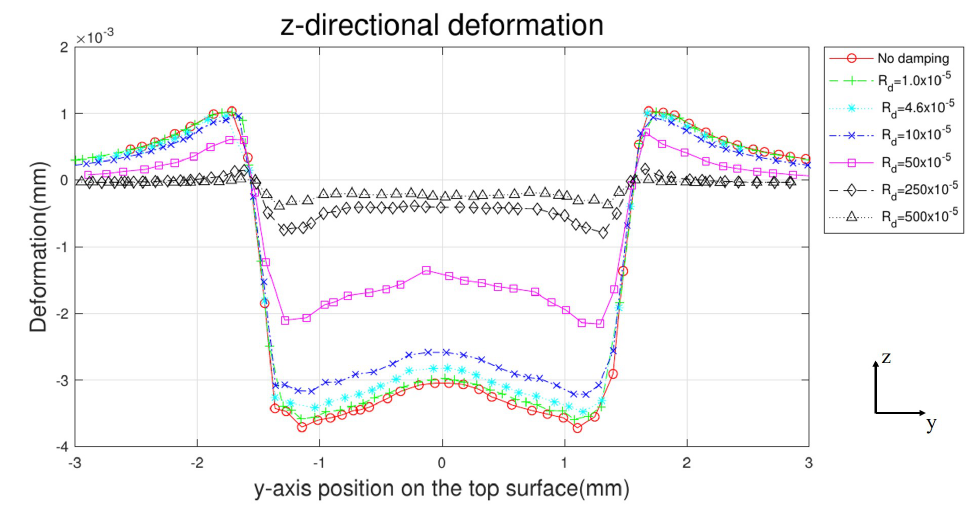
Figure 10. Z-directional deformation distribution on the top